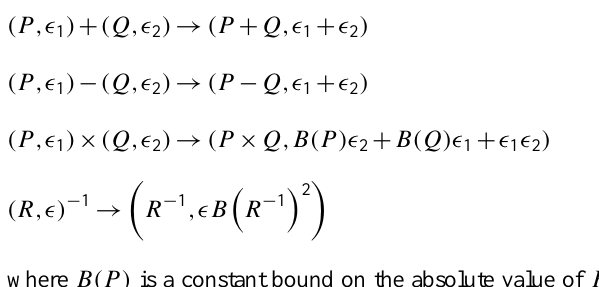
Fig. 2. Program to simulate an atom bouncing around a 2-dimensional box.